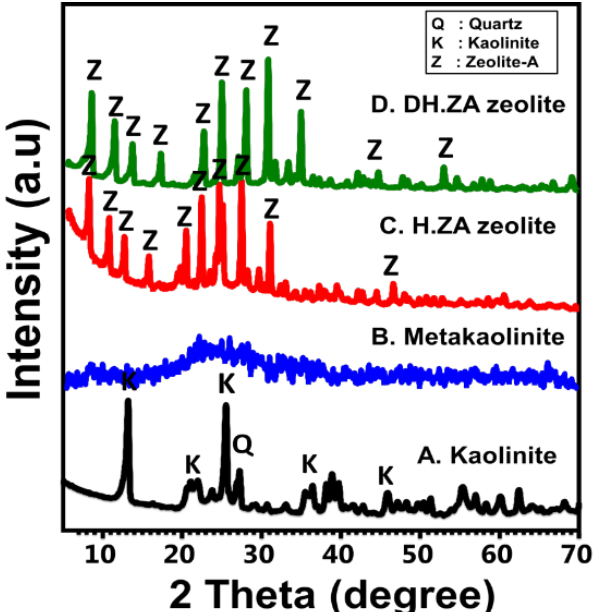
Figure 1. XRD patterns of raw kaolinite ( A ), metakaolinite ( B ), and synthetic zeolite-A by conven- tional method (hydrated zeolite) ( C ) and synthetic zeolite-A by alkali fusion method (dehydrated zeolite) ( D ).